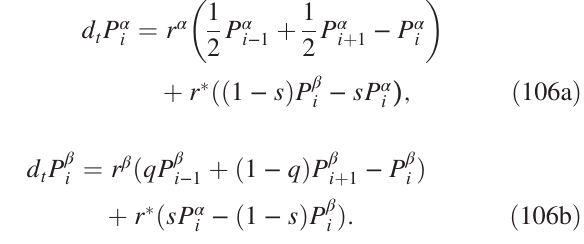
FIG. 4. The Fisher information of all states (black lines) and of only the activity (orange lines) for the sensory adaptation model; the solid lines are the result of Monte Carlo simulations ( 5 × 10 4 samples), and the dashed lines are obtained by solving the master equation corresponding to Eq. (103) directly. While the total Fisher information decays monotonically, the partial Fisher information of only the activity states exhibits a nonmonotonic behavior.